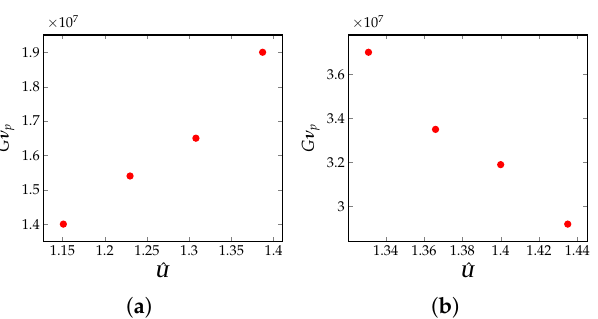
Figure 9. ( a ) Variation of the dimensional cooling rate, G ν p , with ˆ U = a 0 + a a E + a 2 Pe , plotted on a log–log scale. Here, ˆ U is changed by changing E , but keeping Pe fixed for SS316 alloy, ( b ) Variation of dimensional cooling rate, G ν p , with ˆ U = a 0 + a a E + a 2 Pe , plotted on a log–log scale. Here, ˆ U is changed by changing Pe , but keeping E fixed for SS316